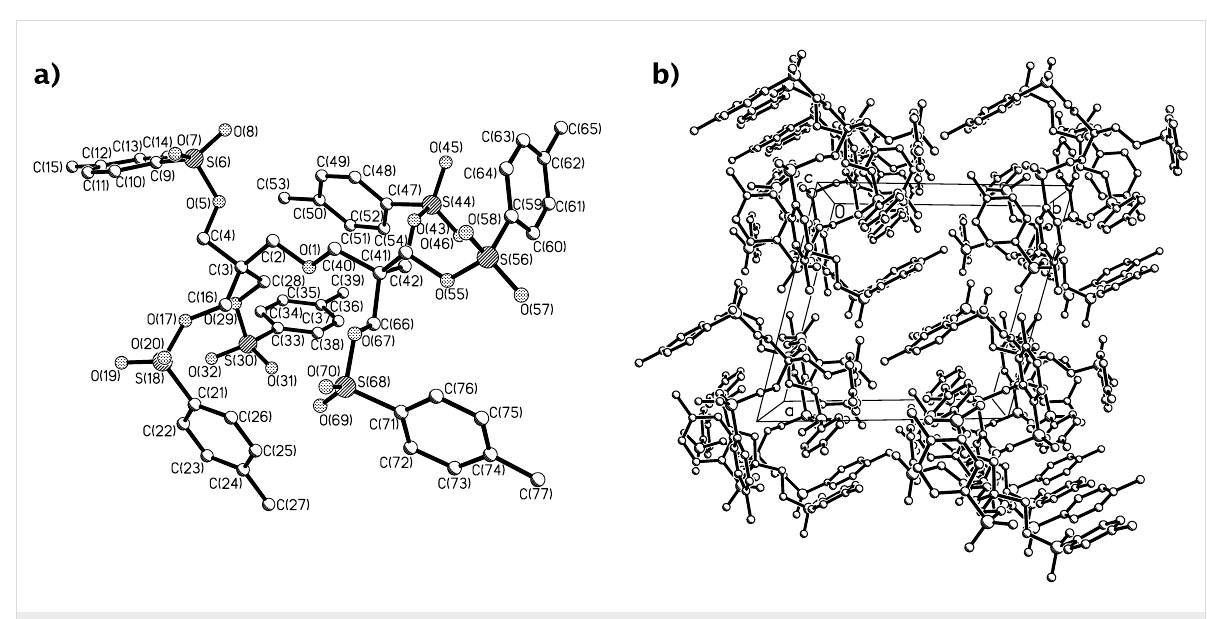
Figure 6: Molecular structure a) and packing diagram b) of the structure of dipenthaerythritol tetra-tosylate (HexaTos).